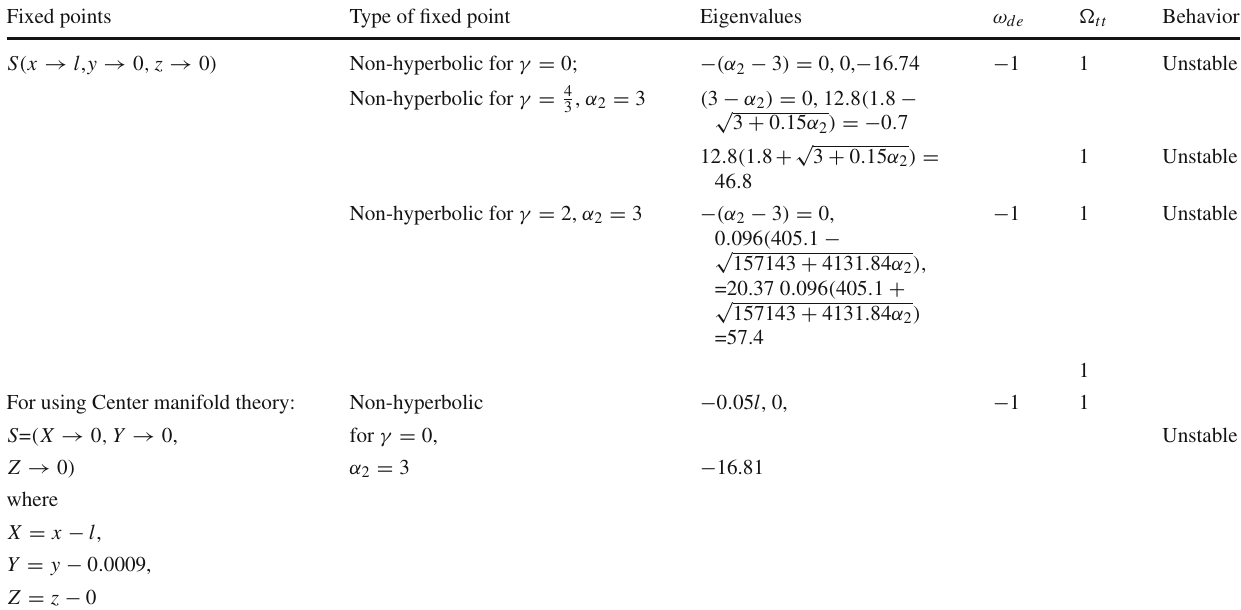
Table 3 Table for Case III ( ˙ G (cid:2)= 0, ˙ ρ (cid:2) (cid:2)= 0) Fixed points